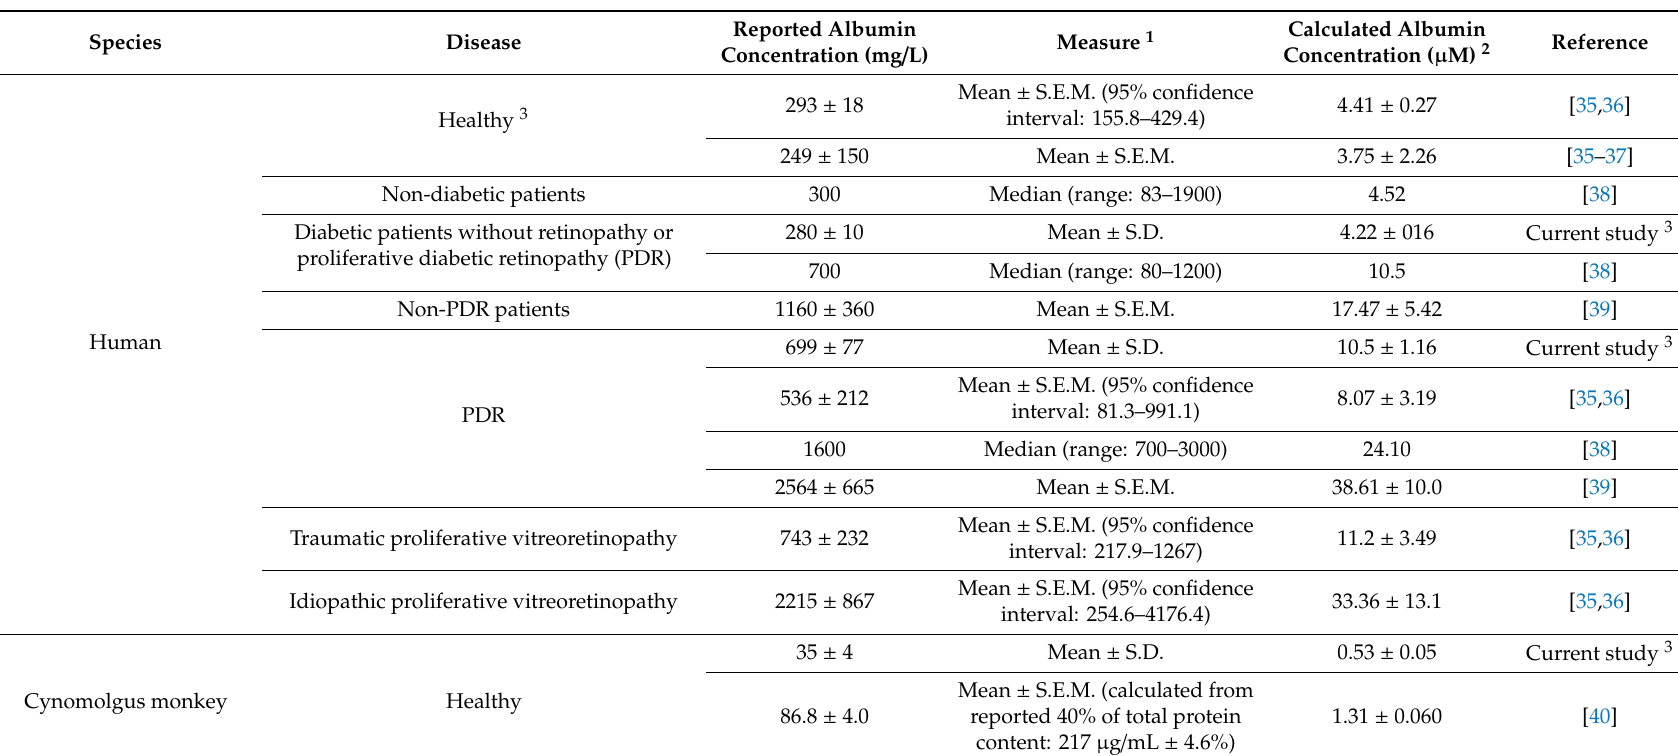
Table 1. Summary of literature values of albumin concentration in the VH of healthy humans and cynomolgus monkeys, as well as patients undergoing